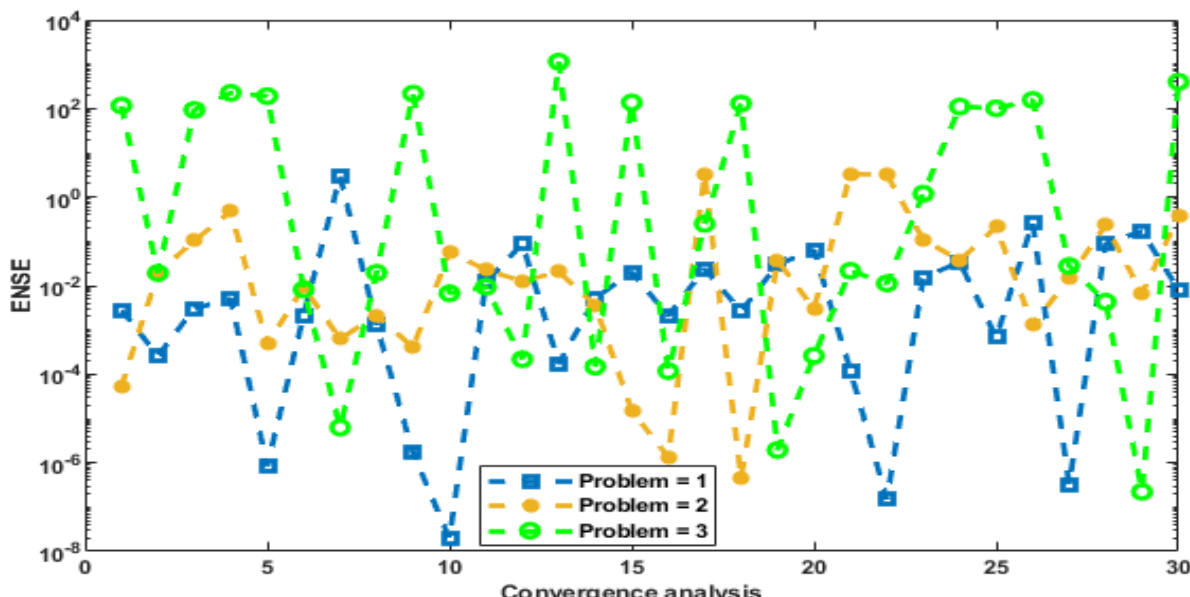
Figure 6. Convergence performance of TIC for each problem of the HO-NSDM.